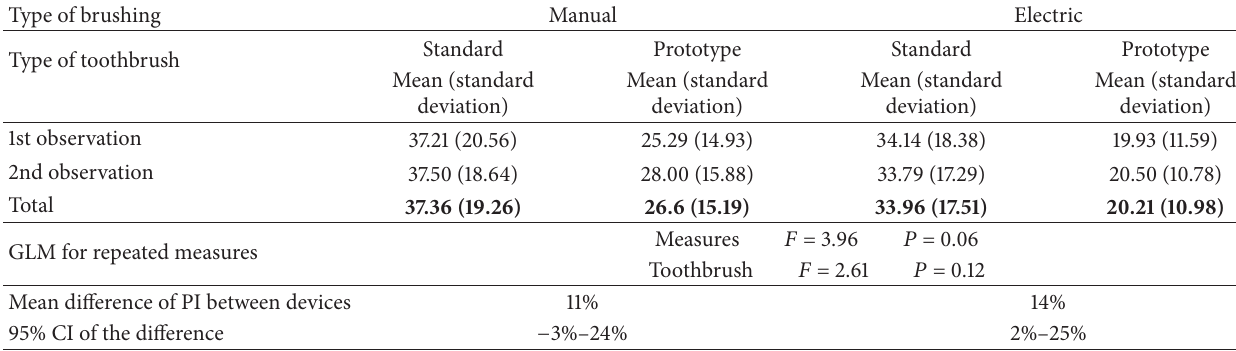
Table 2: % PI for type of toothbrush for the 14 casts ( % PI data ) .